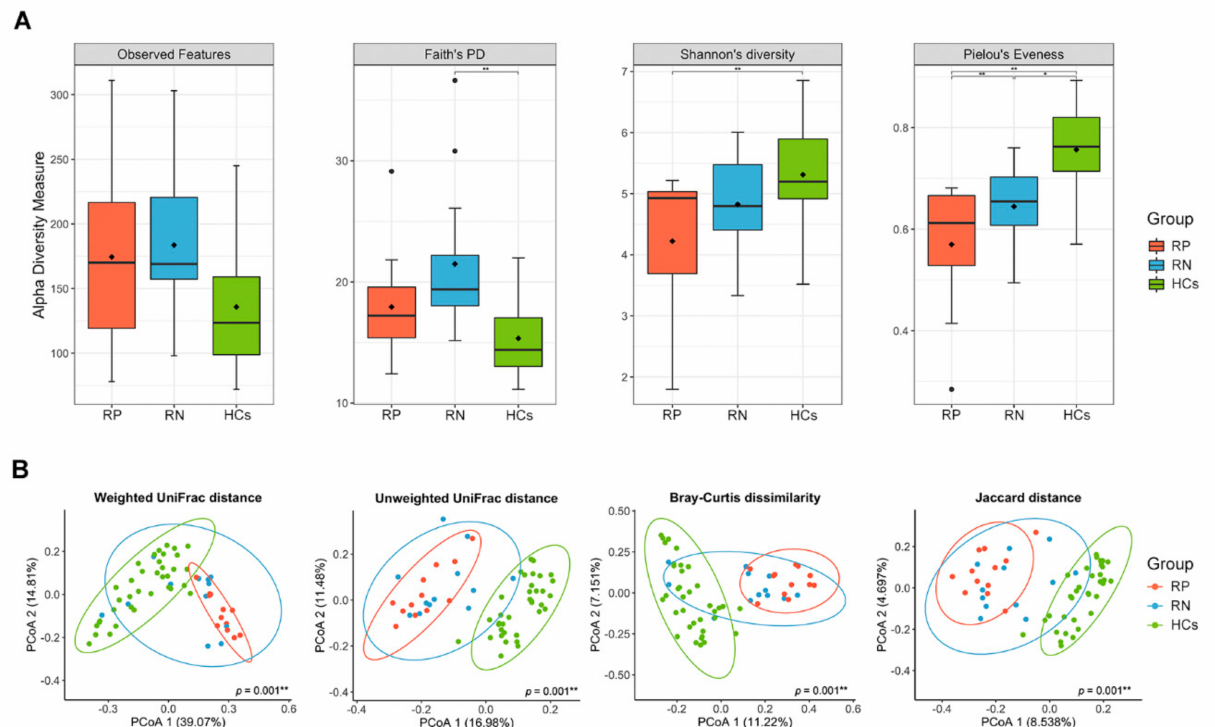
Figure 6. Comparison of the gut microbial diversity among respiratory positive (RP)-SARS-CoV-2, respiratory negative (RN)-SARS-CoV-2, and healthy controls. ( A ) Alpha diversity. The interquartile range (IQR) is the 25th to 75th percentile. The median and mean values are shown as a line and diamond within the box, respectively. The p -values were calculated using mixed model. ( B ) Beta diversity. Each point represents a single sample with ellipses for the 95% confidence interval for each group. The p -values were calculated using pairwise permutational multivariate analysis of variance (PERMANOVA) test with 999 random permutations. * p < 0.05, ** p < 0.01. RP, respiratory positive SARS-CoV-2; RN, respiratory negative SARS-CoV-2; HCs, healthy